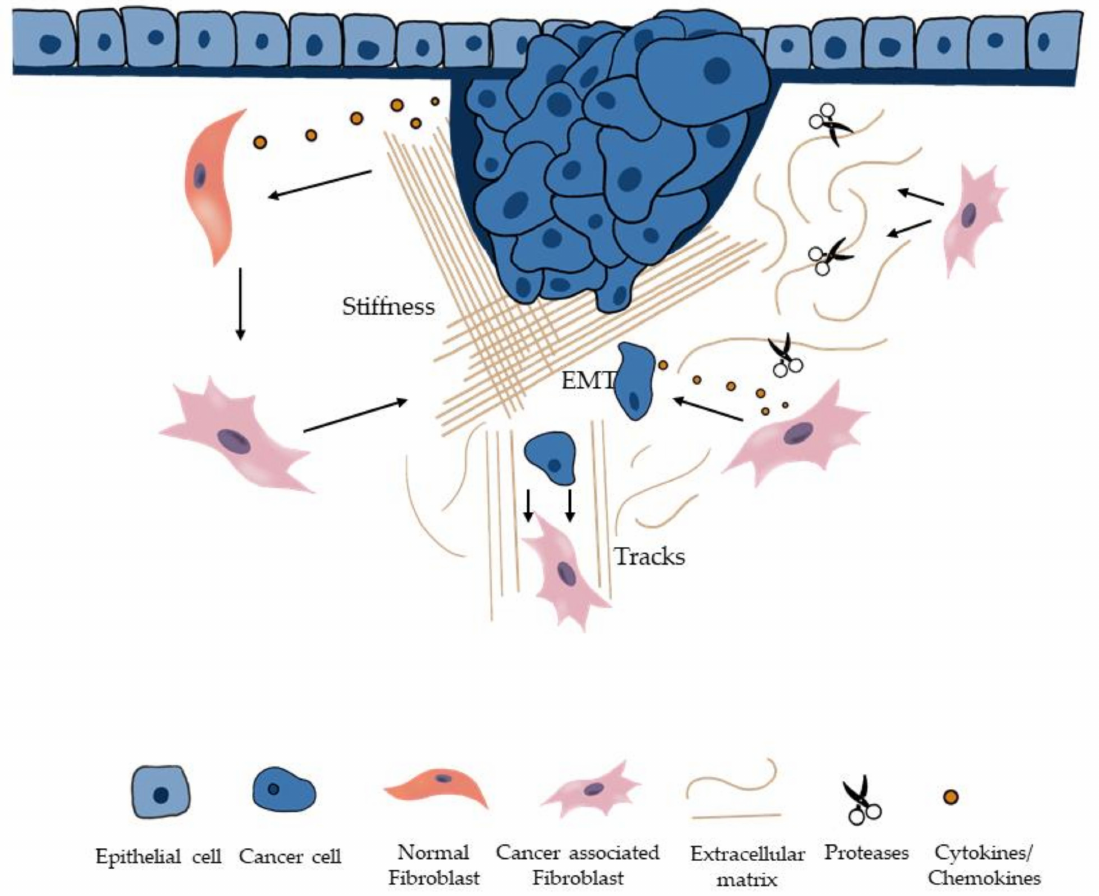
Figure 1. ECM remodeling and EMT modulated by CAFs. CAFs can modify ECM to promote invasion and metastasis of cancer cells by: inducing matrix stiffness; creating tracks for cancer cell invasion; secreting proteases and cytokines. CAFs can also induce